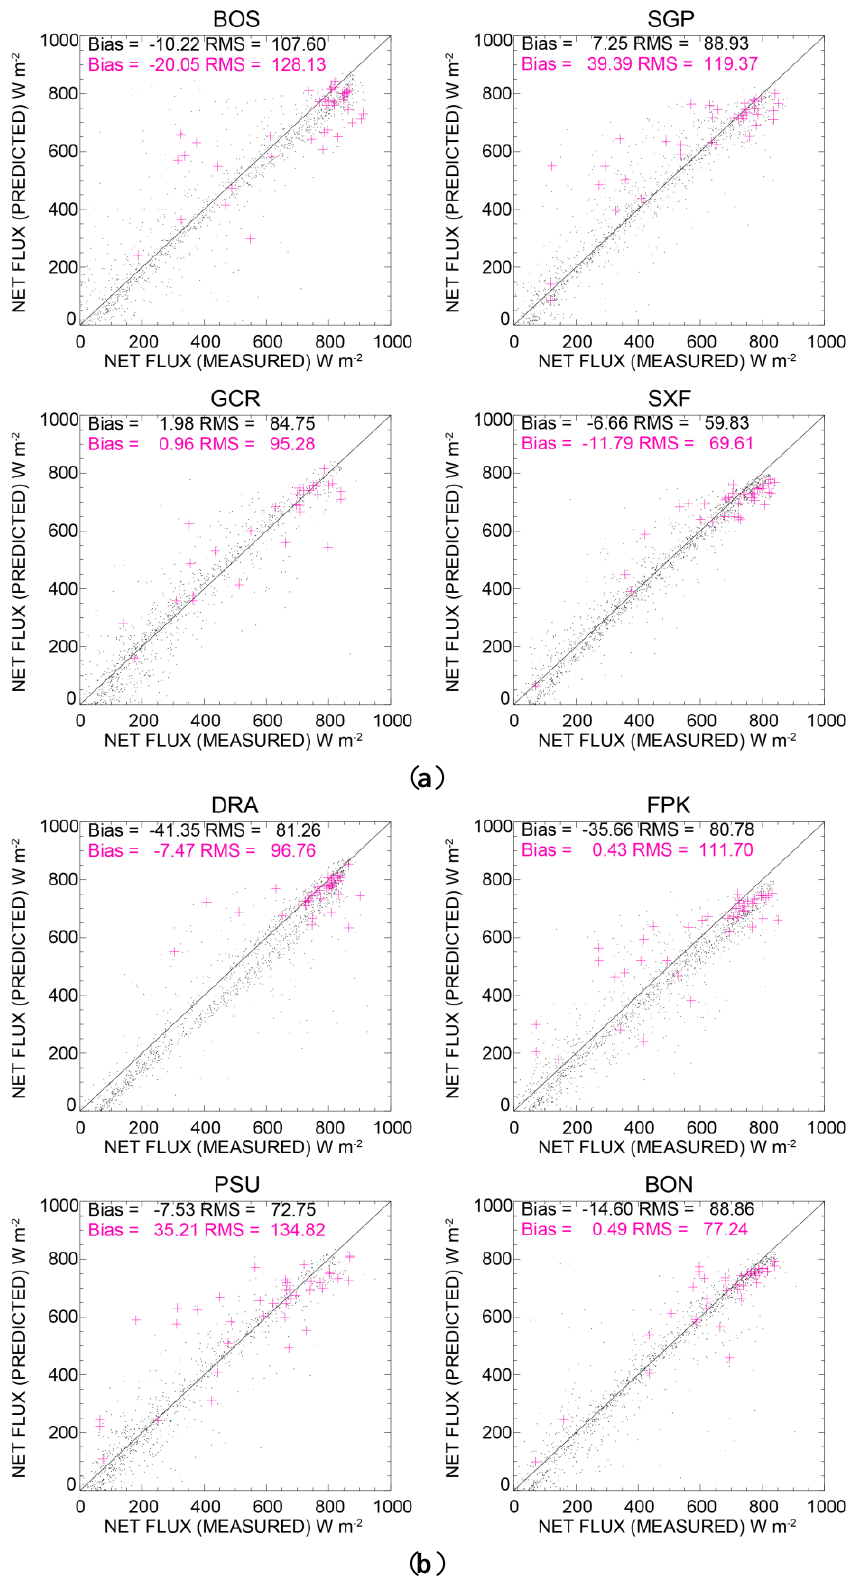
Figure 5. ( a ) Scatter plots of measured vs predicted net surface fluxes for the BOS, SGP, GCR and SXF sites for the month of July 2007; ( b ) Same as Figure 4a, but for the DRA, FPK, PSU and BON sites, showing the effect of larger MISR AODs on the surface net